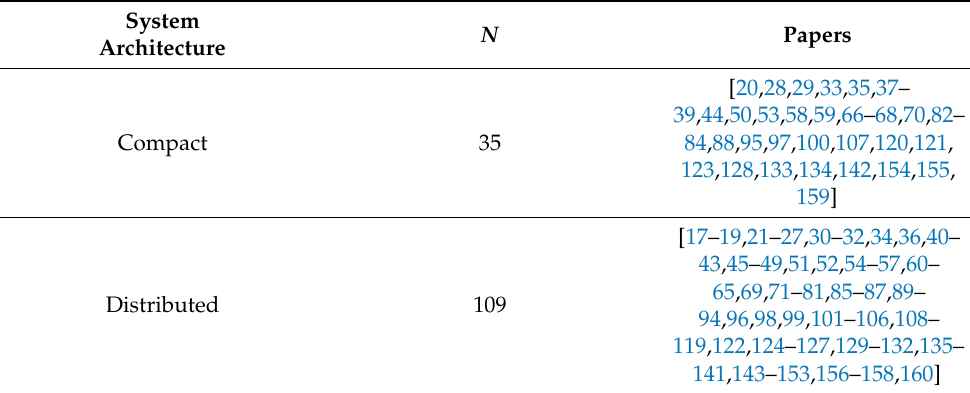
Table 5. BMF system architecture.